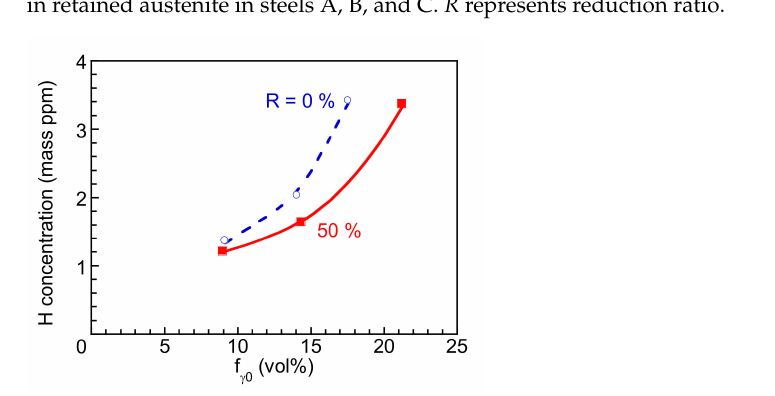
Figure 14. Variations in diffusible hydrogen concentration ( H C ) as a function of initial volume fraction of retained austenite ( f γ 0 ) in steels A, B, and C. R represents reduction